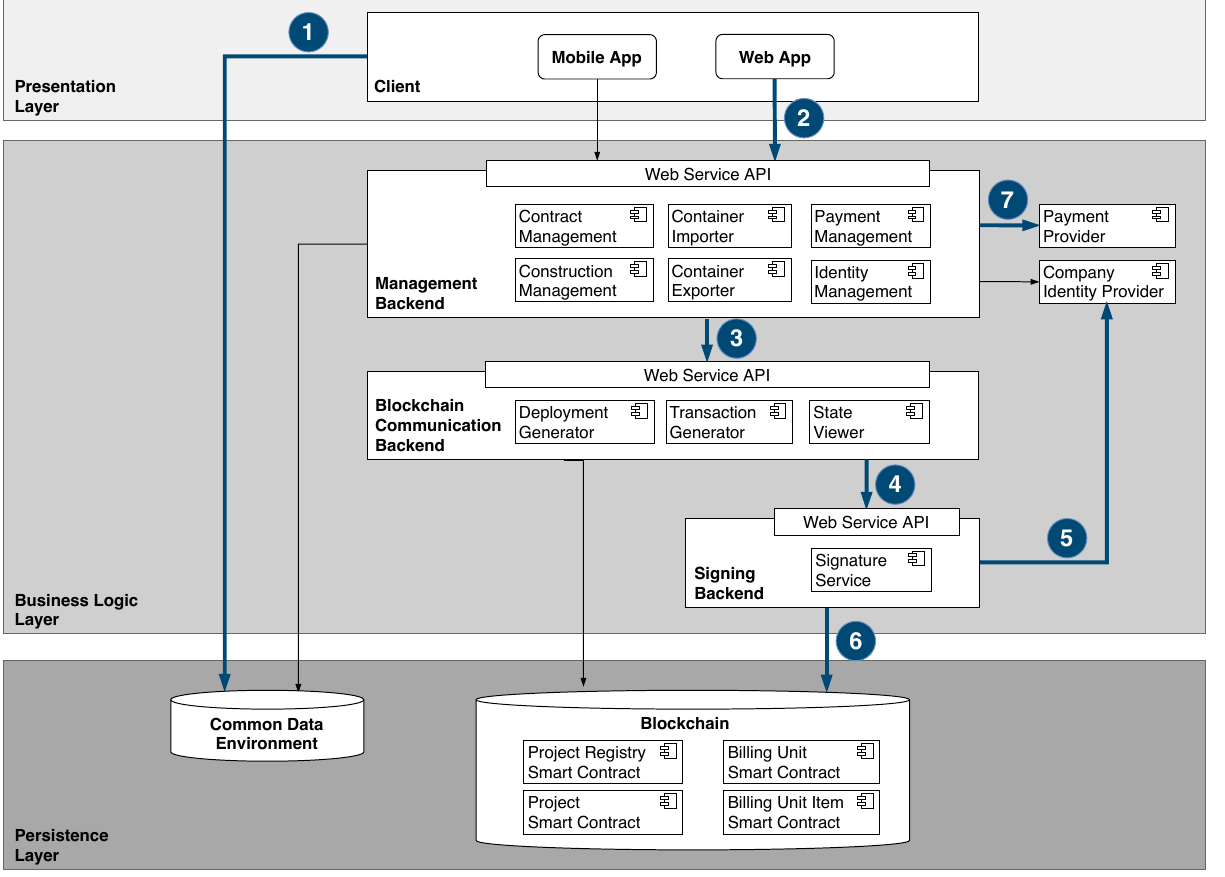
Figure 6. Confirmation process within the system